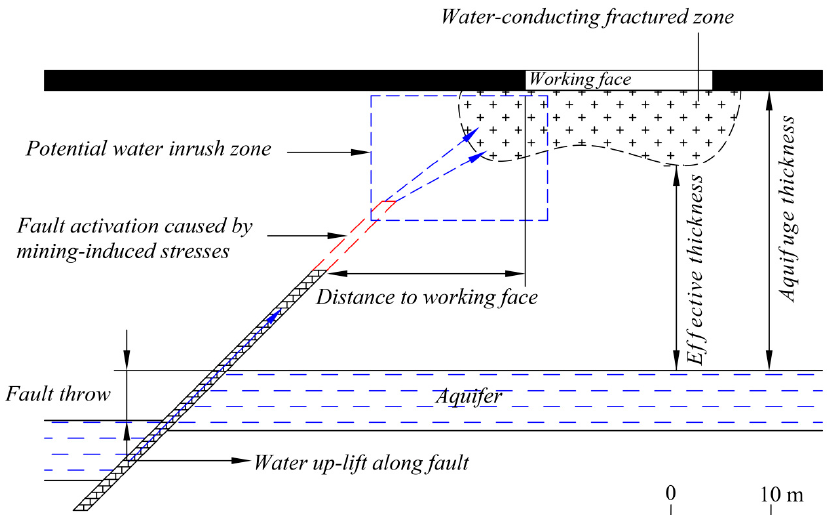
Figure 3. A small fault is connected to an aquifer but not to a coal seam.